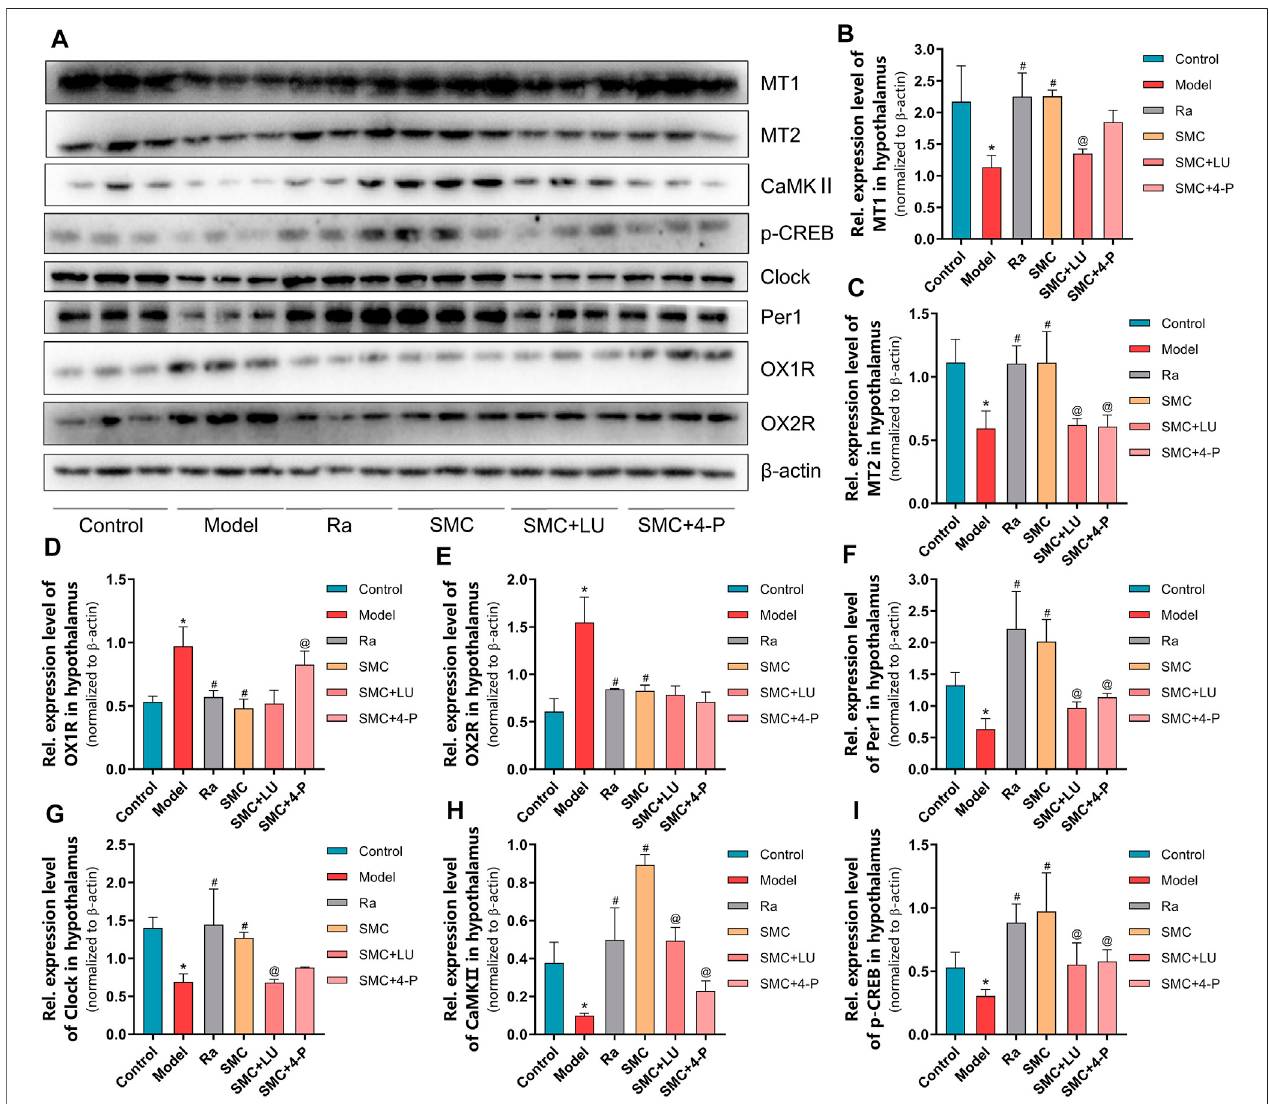
FIGURE 8 | The changes of melatonin receptors and their related proteins in sleep-deprived mice after being treated with ramelteon, SMC, as well as melatonin receptorantagonistsluzindoleand4-P-PDOT( n =3). (A) Westernblottingresults.StatisticaldataoftheMT1levels (B) ,theMT2levels (C) ,theOX1Rlevels (D) ,theOX2R levels (E) ,thePer1levels (F) ,theclocklevels (G) , theCaMK Ⅱ levels (H), and thep-CREBlevels (I) .* p < 0.05 vs .controlgroup; # p < 0.05 vs .modelgroup;@ p < 0.05 vs . SMC group. All the data were represented as the mean ± SD.